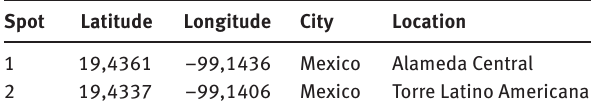
Table 2: Location of the HVSR measures.